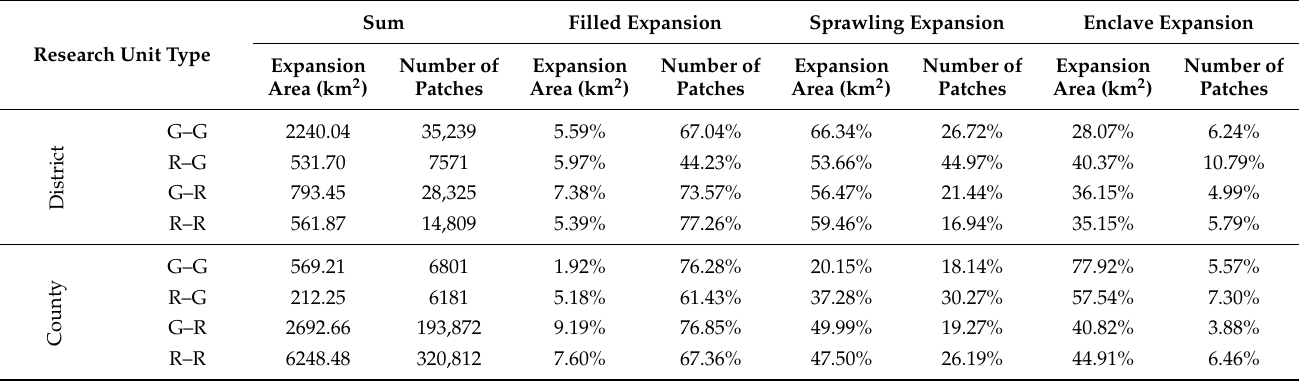
Table 3. The proportion of expansion areas and number of patches of new construction land in different expansion modes in each research unit,